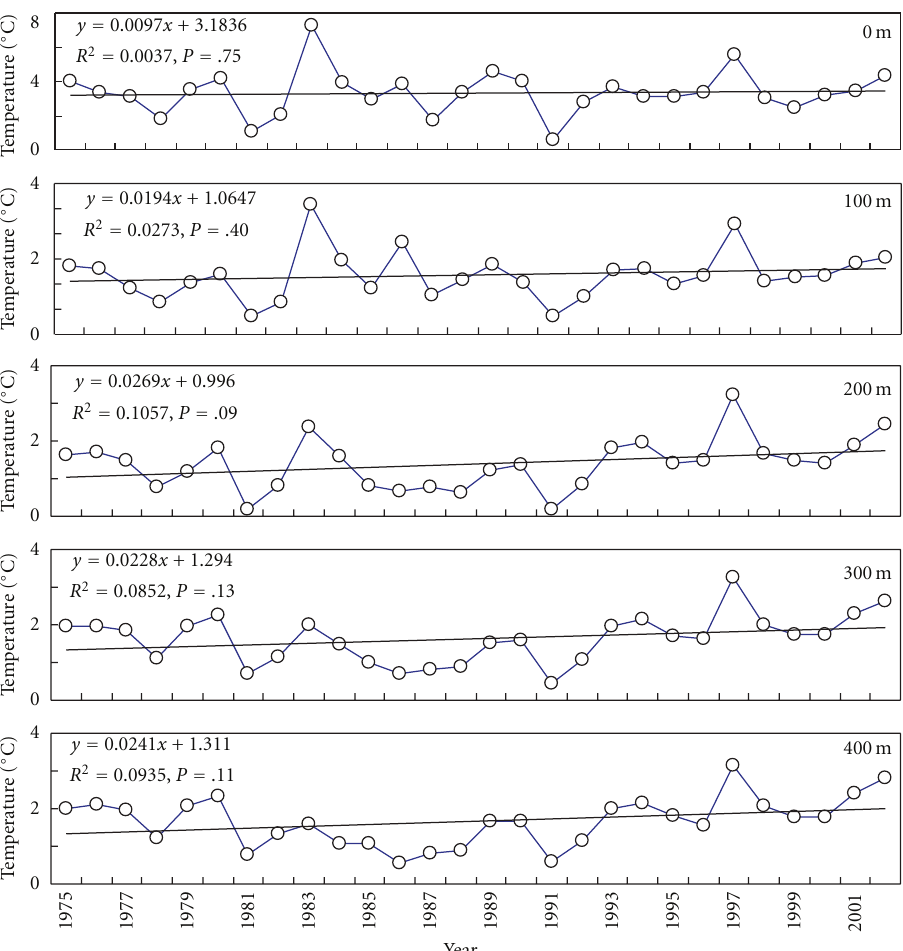
Figure 4: Long-term time series of the mean sea water temperature at the surface, 100m, 200 m, 300m, and 400 m during austral summer (January–March) between 1975 and 2002. Solid lines represent linear